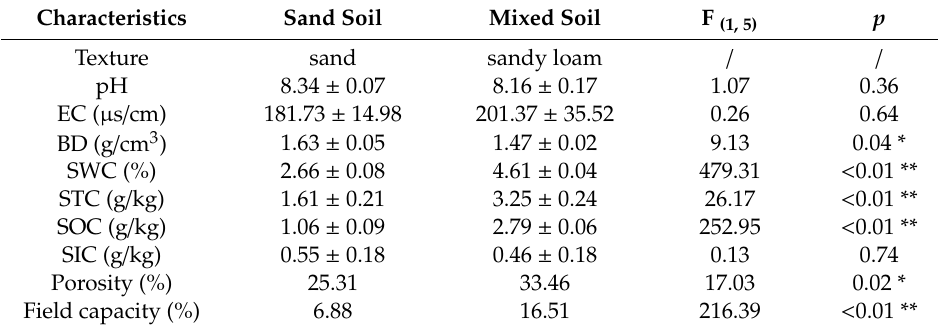
Table 2. Soil characteristics in sand vs. a mix of sand and feldspathic sandstone.